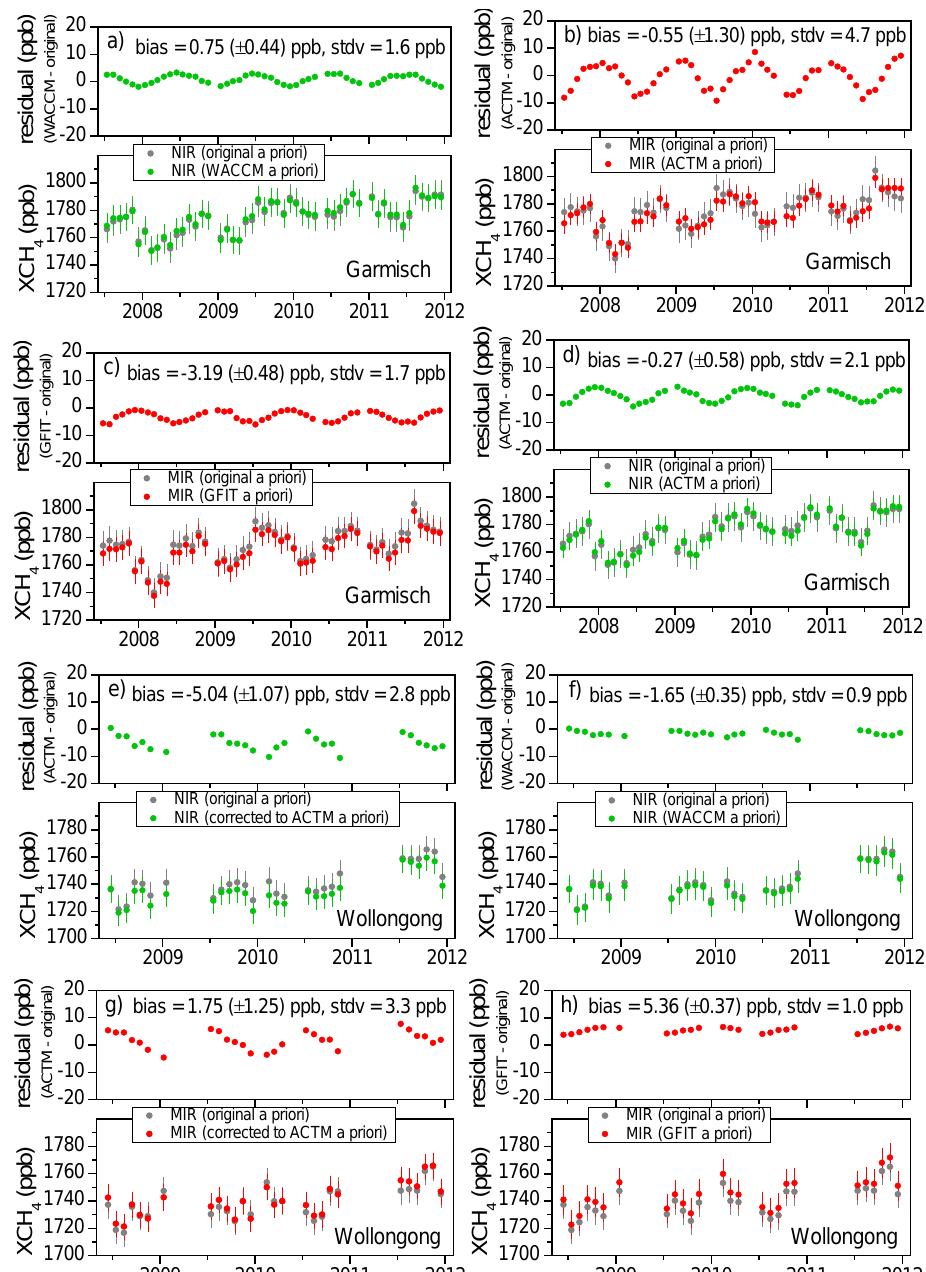
Fig. C1. Same as Fig. 3 but showing the impact on (a) Garmisch NIR retrievals using the Garmisch WACCM a priori profile (i.e. the standard prior of the Garmisch MIR retrievals) as prior, (b) Garmisch MIR retrievals using 3-hourly ACTM profiles, (c) Garmisch MIR retrievals using the GFIT a priori profile (i.e. the standard prior of the NIR retrievals), (d) Wollongong NIR retrievals using 3-hourly ACTM profiles, (e) Wollongong NIR retrievals using the WACCM a priori profile, (f) Wollongong MIR retrievals with the a priori profile corrected to 3-hourly ACTM profiles via Eq. (1), and (g) Wollongong MIR retrievals using the GFIT a priori